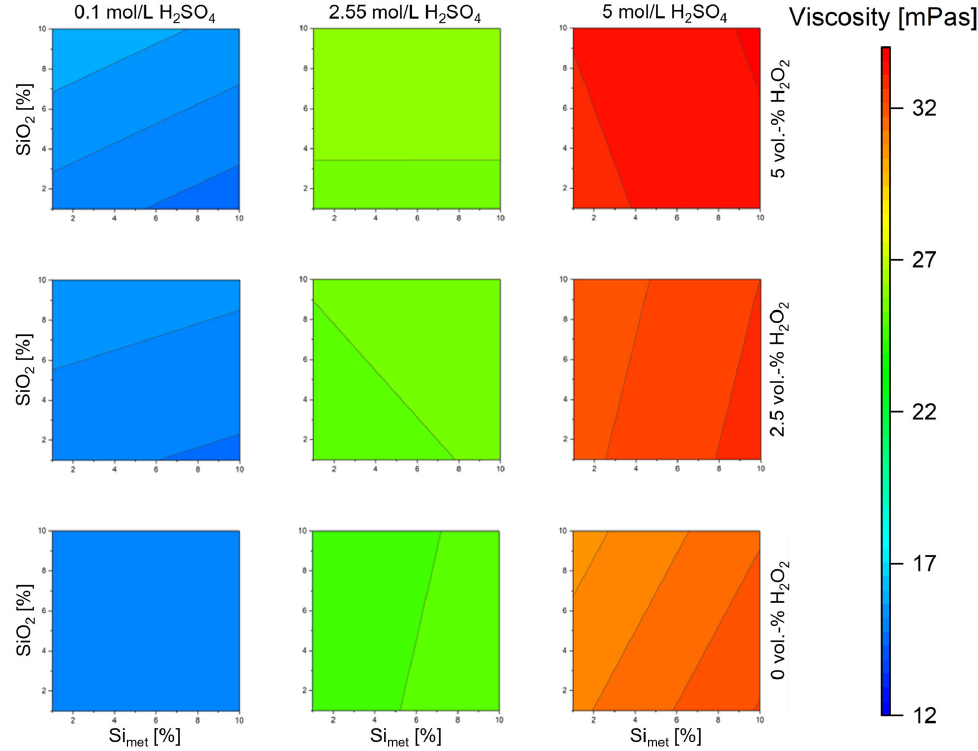
Metals 2023 , 13 , x FOR PEER REVIEW Figure 9. 4D contour plot for the change in viscosity as a function of Si met , SiO 2 , H 2 SO 4 and H 2 O 2 concentration in the leaching solution at an S/L ratio of 100 g/L and a leaching temperature of 80 °C. Based on these evaluations, the leaching efficiencies for the valuable metals cobalt, nickel, lithium and manganese are evaluated, taking into account the Si met and SiO 2 con ‐ tents in the pregnant leaching solutions. As can be seen in Figure 10, Co, Ni and Mn show similar behaviour in the context of leaching without the addition of H 2 O 2 but with the maximum silicon addition (Si met + SiO 2 ). Lithium, on the other hand, completely dissolves from a H 2 SO 4 concentration of approx. 2.2 mol/L, regardless of the leaching temperature. This is also in line with experience from previous research and literature, as lithium can be rapidly and easily converted into solution. It is also shown that with a fixed leaching period of 240 min, the maximum achievable leaching rates are already attainable with the application of a 3 ‐ molar H 2 SO 4 leaching system and temperatures of approx. 75 °C.